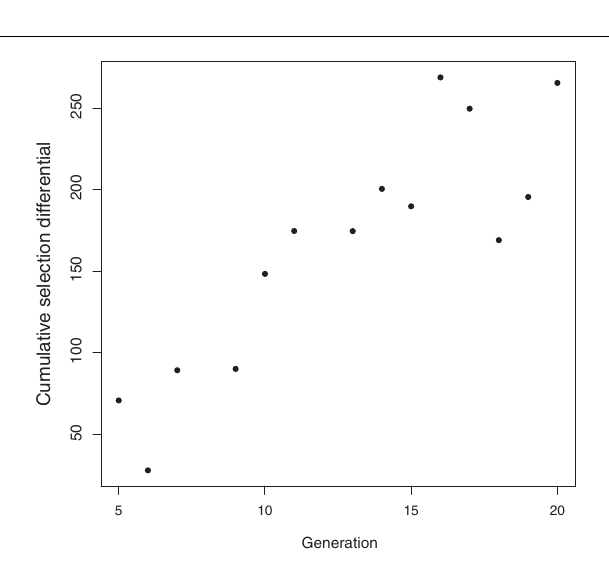
FIGURE 3 | Generation mean cumulative selection differentials for postweaning gain (kg) in Line 1 Hereford cattle.